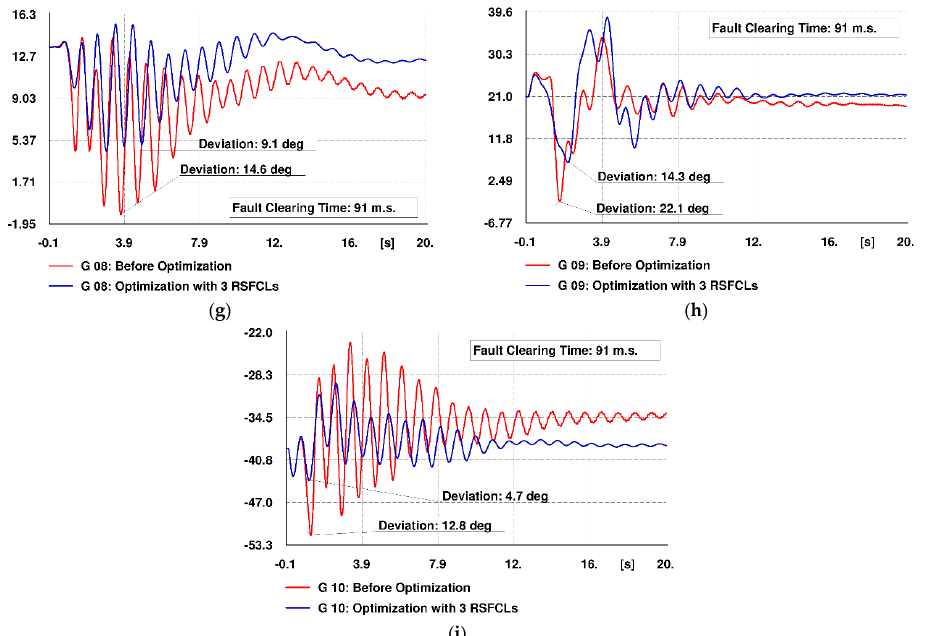
Figure 13. Rotor angle oscillation of generators in Scenario 1 with reference to the reference machine “with” and “without” optimized RSFCLs. ( a ) Generator G1, ( b ) Generator G3, ( c ) Generator G4, ( d ) Generator G5, ( e ) Generator G6, ( f ) Generator G7, ( g ) Generator G8, ( h ) Generator G9, ( i ) Generator G10.